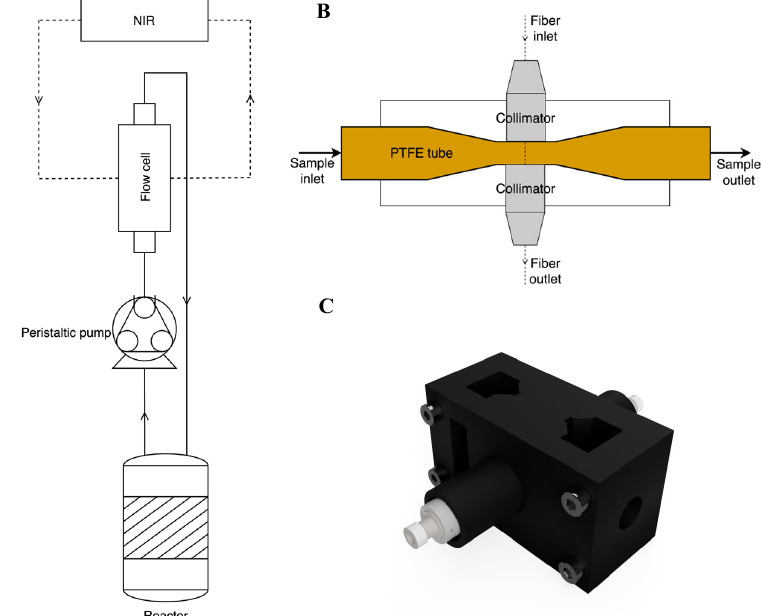
Figure 2. ( A ) Layout of sample loop. The experimental setup includes a stirred reactor, a peristaltic pump, a flow cell and a NIRS instrument. ( B ) Cross-sectional layout of flow cell. ( C ) Assembled flow cell with collimators.